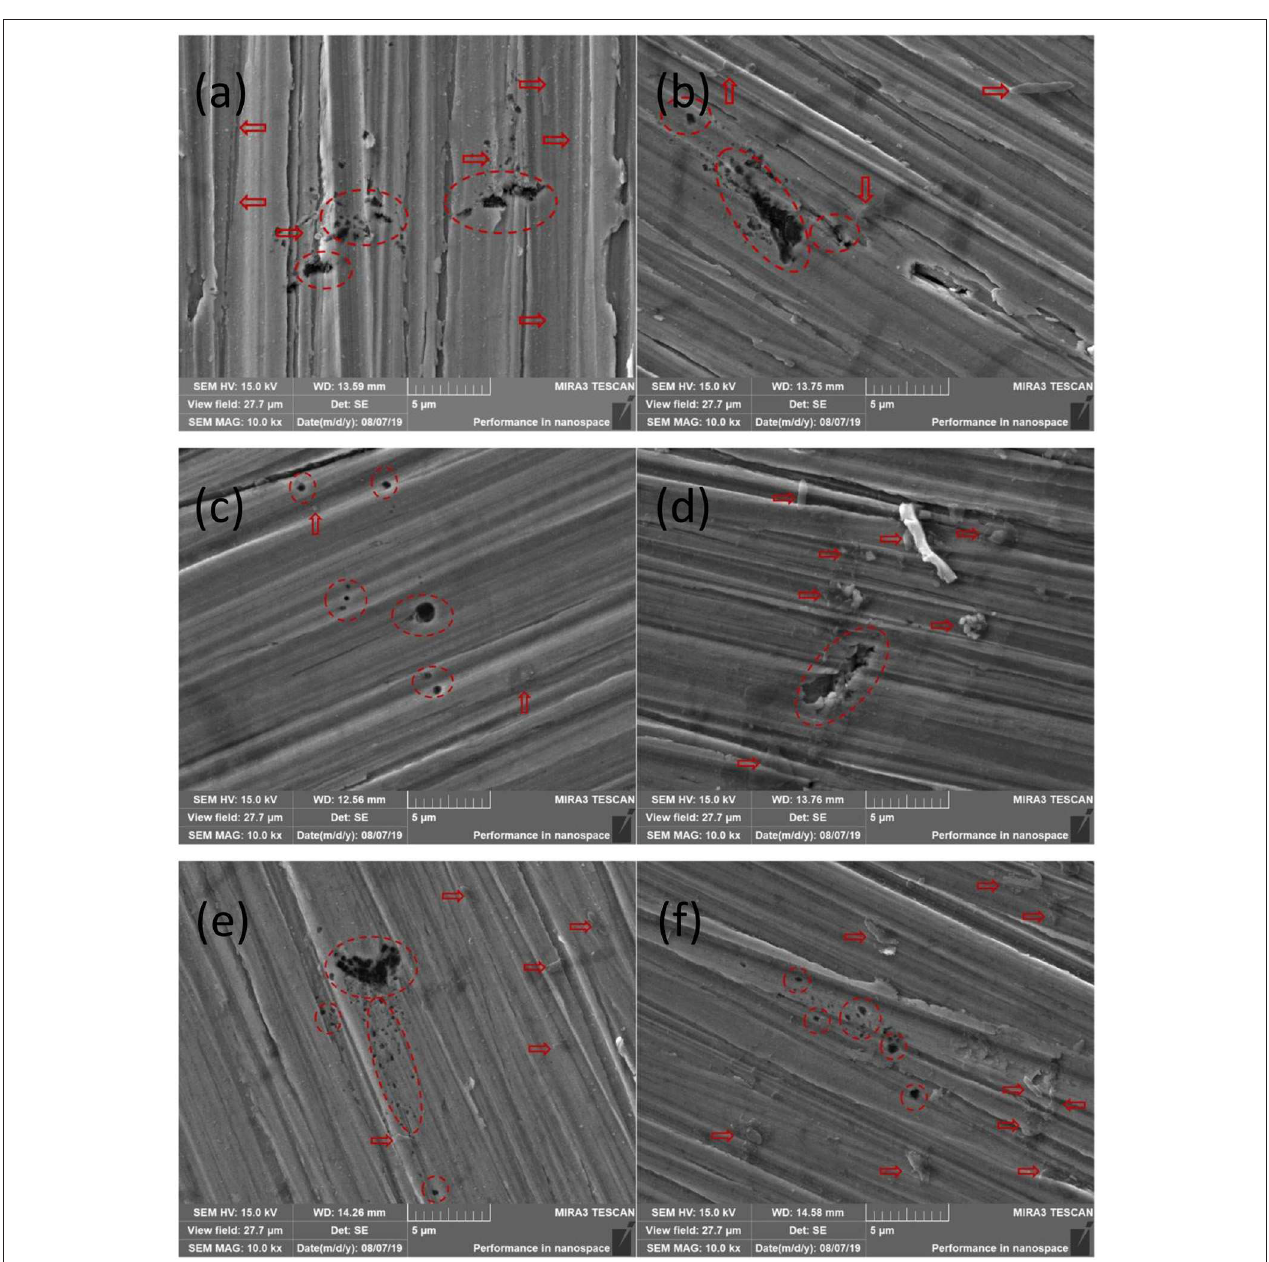
FIGURE 4 | Scanning electron microscopy (SEM) morphologies of pits on surfaces of coupons: (a) A1 base metal, (b) A1 weld seam, (c) A2 base metal, (d) A2 weld seam, (e) D1 base metal, and (f) D1 weld